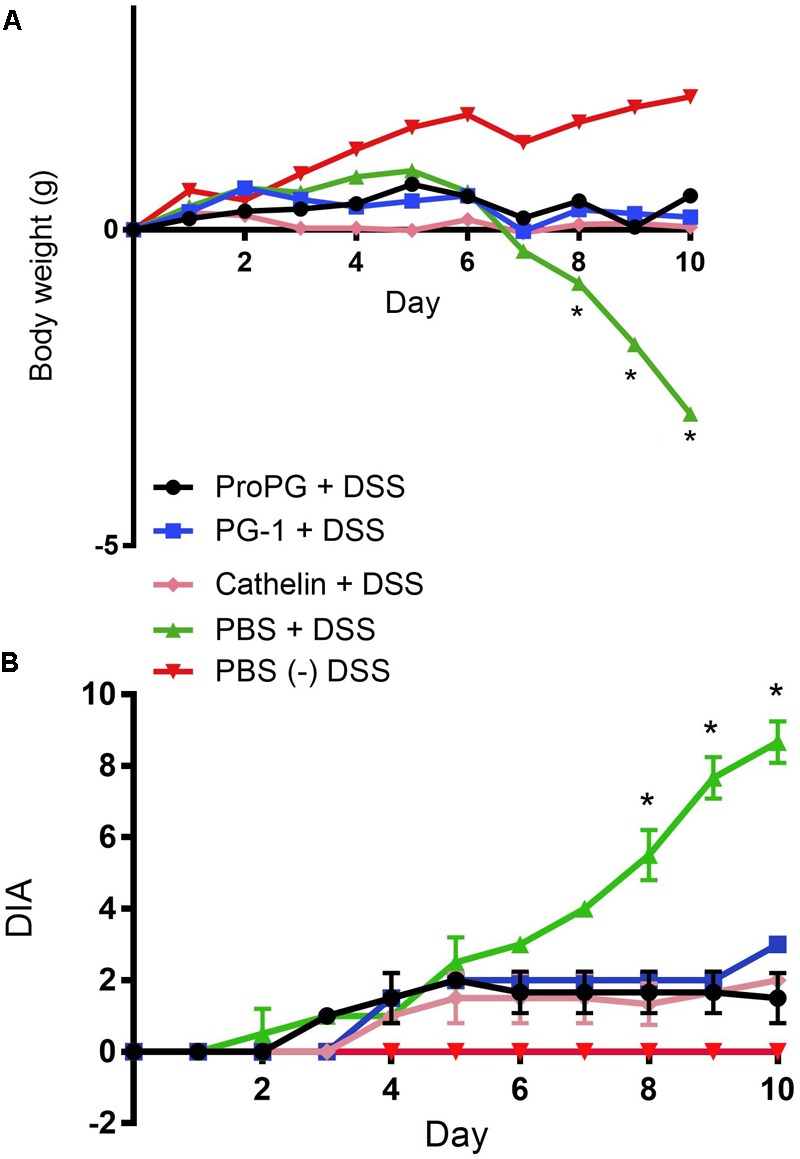
Protegrin treatments ameliorate weight loss and disease activity index (DAI) in DSS-induced colitis in mice. By day 8, mice administered DSS and treated with protegrin [pro-form (ProPG) Cathelin or mature PG-1] have significantly (∗P < 0.05) significantly less weight loss (A) and improved total DAI scores (B) compared to the mice administered DSS but given PBS instead of protegrin (PBS + DSS). PBS: mice not administered DSS, treated with PBS. Higher DAI score indicates more severe disease signs. Significance was determined using a one-ray ANOVA with a post hoc Tukey test. Data represent the mean ± SEM of 12 mice per treatment.